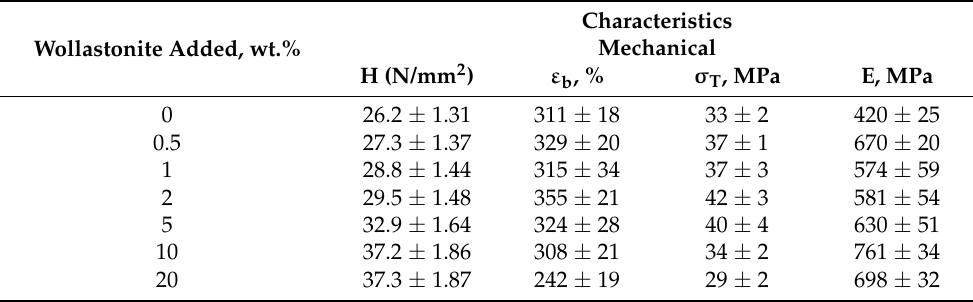
Table 1. Hardness, elongation at break, tensile strength, and Young’s modulus of ultra-high-molecular weight polyethylene (UHMWPE) and polymer composite materials (PCM).